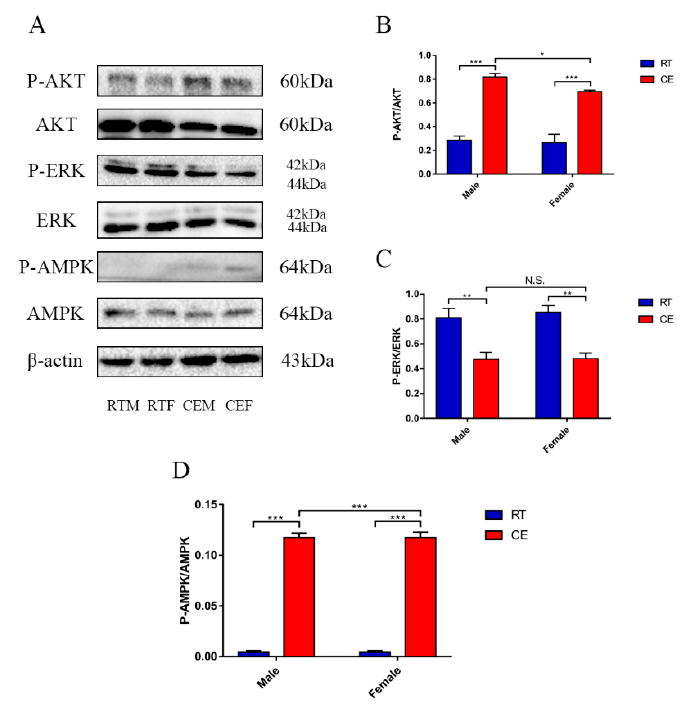
Figure 4. The relevant signaling pathway expression of key proteins in the hippocampus lysates as assessed by western blotting and relative density analyses ( A ) of v-akt murine thymoma viral oncogene homolog 1 (AKT), P-AKT, mitogen-activated protein kinase 1 (ERK), phospho-mitogen-activated protein kinase 1 (P-ERK), protein kinase, AMP-activated, alpha 1 catalytic subunit (AMPK), phospho-AMP-activated, alpha 1 catalytic subunit (P-AMPK), and β -actin expressions in each group. The expression levels were quantitated by measuring band intensities using Image Lab software. The graphs indicate densitometric analyses using the expression ratios of ( B ) P-AKT / AKT, ( C ) P-ERK / ERK, and ( D ) P-AMPK / AMPK. Data were between room temperature male vs. cold exposure male (CEM), room temperature female vs. cold exposure female (CEF), and CEM vs. CEF, and were analyzed by two-way analysis of variance. The results are expressed as the mean ± SD ( n = 6) from four independent experiments. NS: not significant; ** P < 0.01; *** P < 0.001.